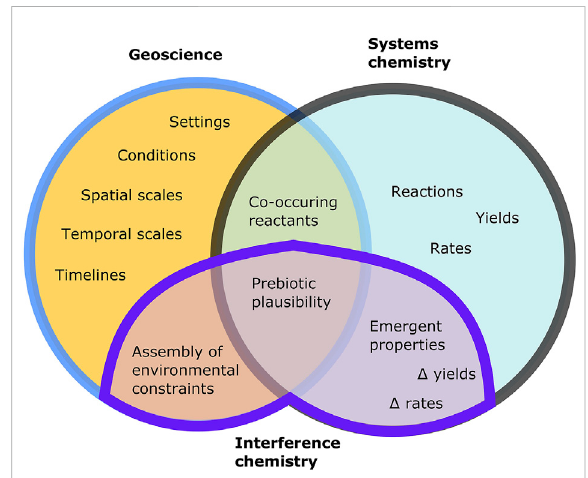
FIGURE 2 Venn-diagram illustrating the constraints that can be achieved on prebiotic scenarios with different scienti fi c approaches. Geoscience can constrain localised environmental chemistry as well as planetary-scale boundary conditions via the analysis of preserved rocks or with theoretical models, while systems chemistry can identify reactions leading to pre-biological molecules. An interference chemistry approach to (i) geoscience involves the systematisation (self-consistency, ranges of uncertainty) of existing constraints, and to (ii) systems chemistry involves the application of interferences to experiments and collation of resulting effect sizes (delta yield/rate, and so on). Where geoscienti fi c, systems chemistry, and interference chemistry constraints all indicate that a scenario is robust, an evaluation of prebiotic plausibility can be assessed (subject to change in all three types of